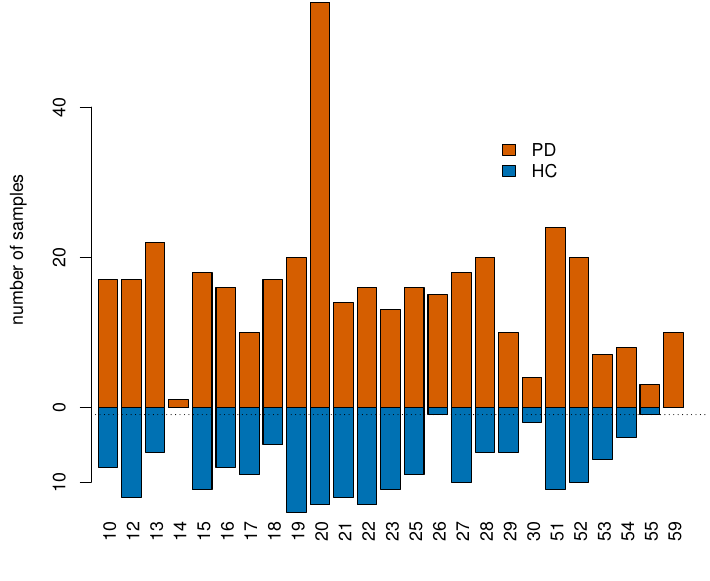
Figure 2. Samples were collected across 25 different sites labeled with an integer number. Sites “14”, “26”, “55”, and “59” had 0 or 1 control sample only (horizontal dotted line) and were excluded from the classification analysis as batch effects due to site could not be estimated and therefore corrected